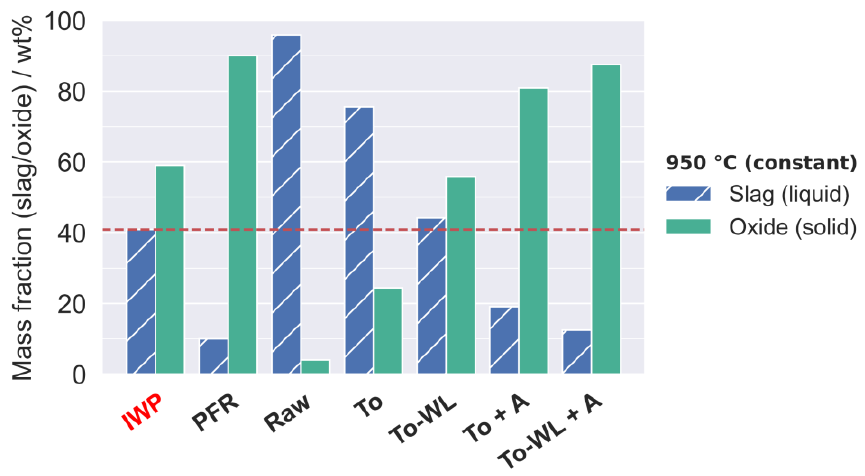
Figure 16. Comparison of the ash fusibility of the investigated samples (according to the calculated phase maps). The dashed red line denotes the amount of molten slag or solid oxides of the benchmark material IWP.